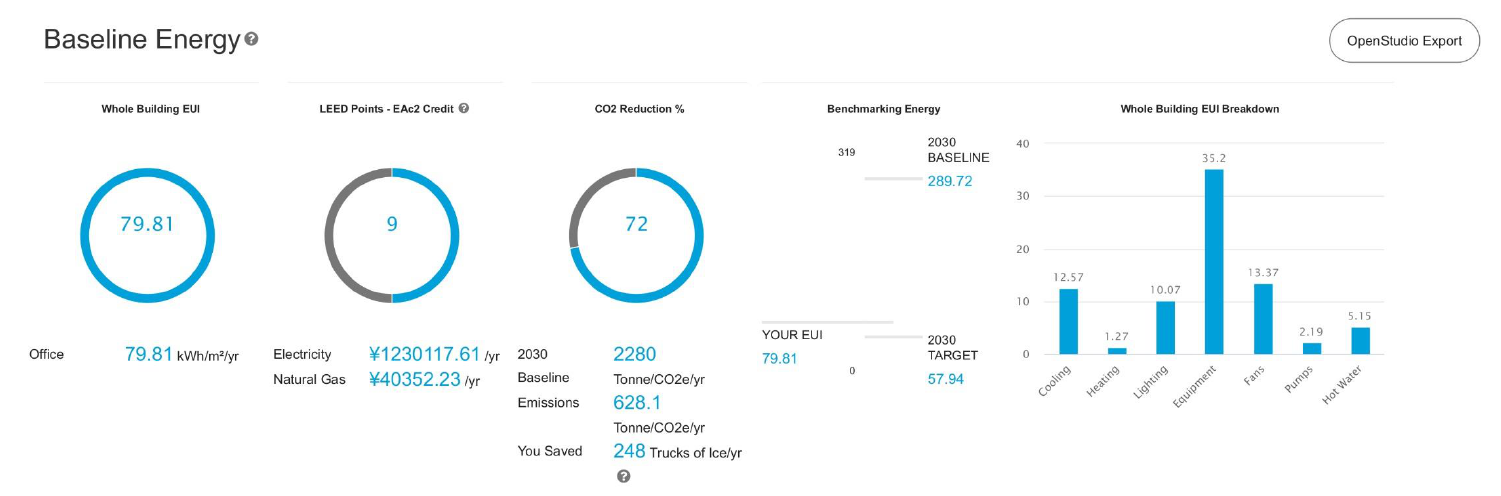
Clean Technol. 2022 , 4 , FOR PEER REVIEW Figure A5. Zone 2-A Guangzhou, Guangdong (post-COVID-19 78% scenario). Figure A5. Zone 2-A Guangzhou, Guangdong (post-COVID-19 78% scenario).